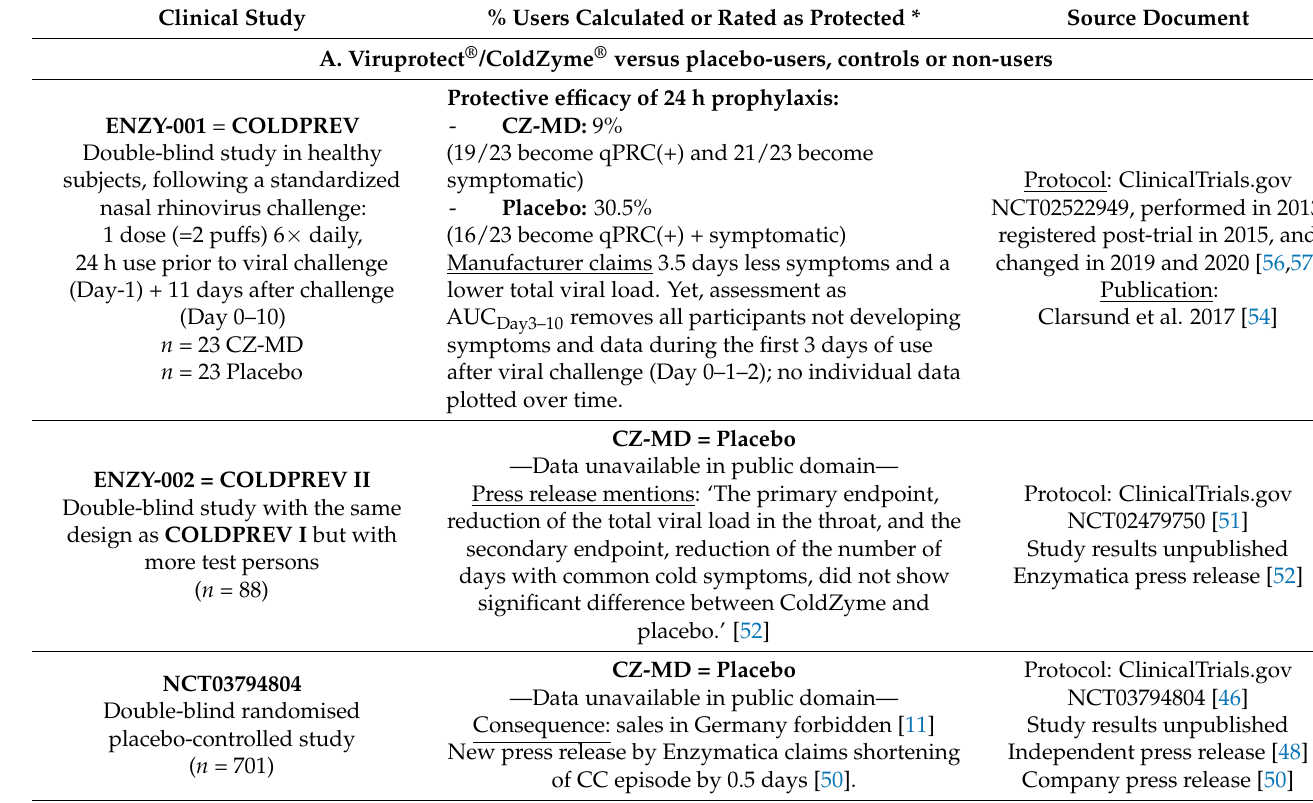
Table 2. Does Viruprotect/ColdZyme (CZ-MD) protect ‘against’ viruses? Clinical outcome as derived from studies assessing CZ-MD and if data available, compared with placebo, controls or non-use. Clinical